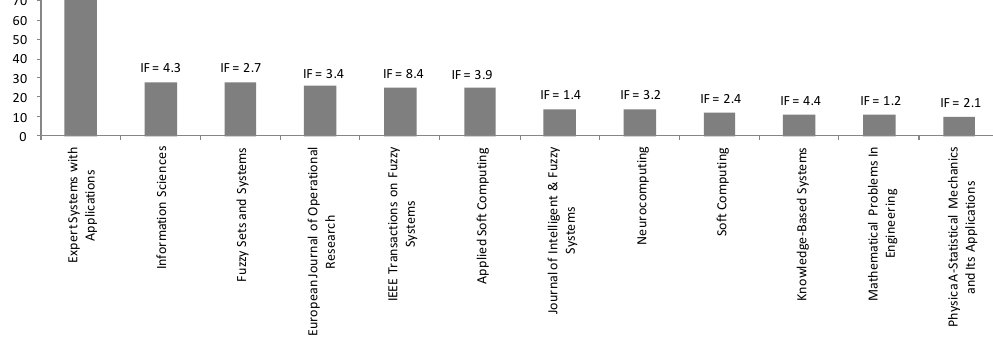
Figure 3. Academic journals that appear with greater frequency in our portfolio and their 2017 impact factors.